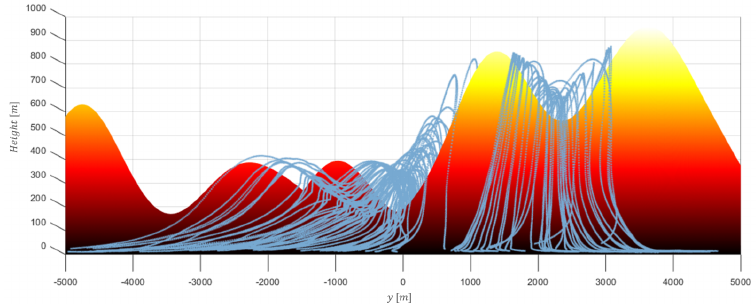
Figure 14. Multiple trajectories of scenario B—side